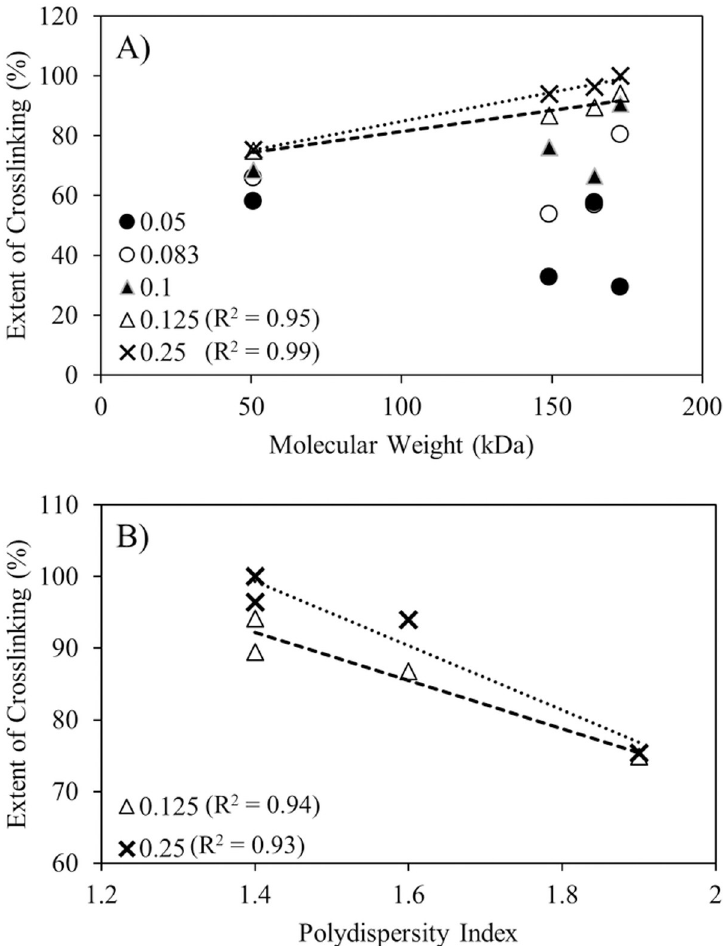
Fig 3. The extent of crosslinking achieved in CLAMs at varying calcium to alginate ratios with respect to A) molecular weight and B) polydispersity of the alginates. Calcium to alginate ratios given in the legends. The R 2 values for linear regressions shown in the graphs are next to the corresponding